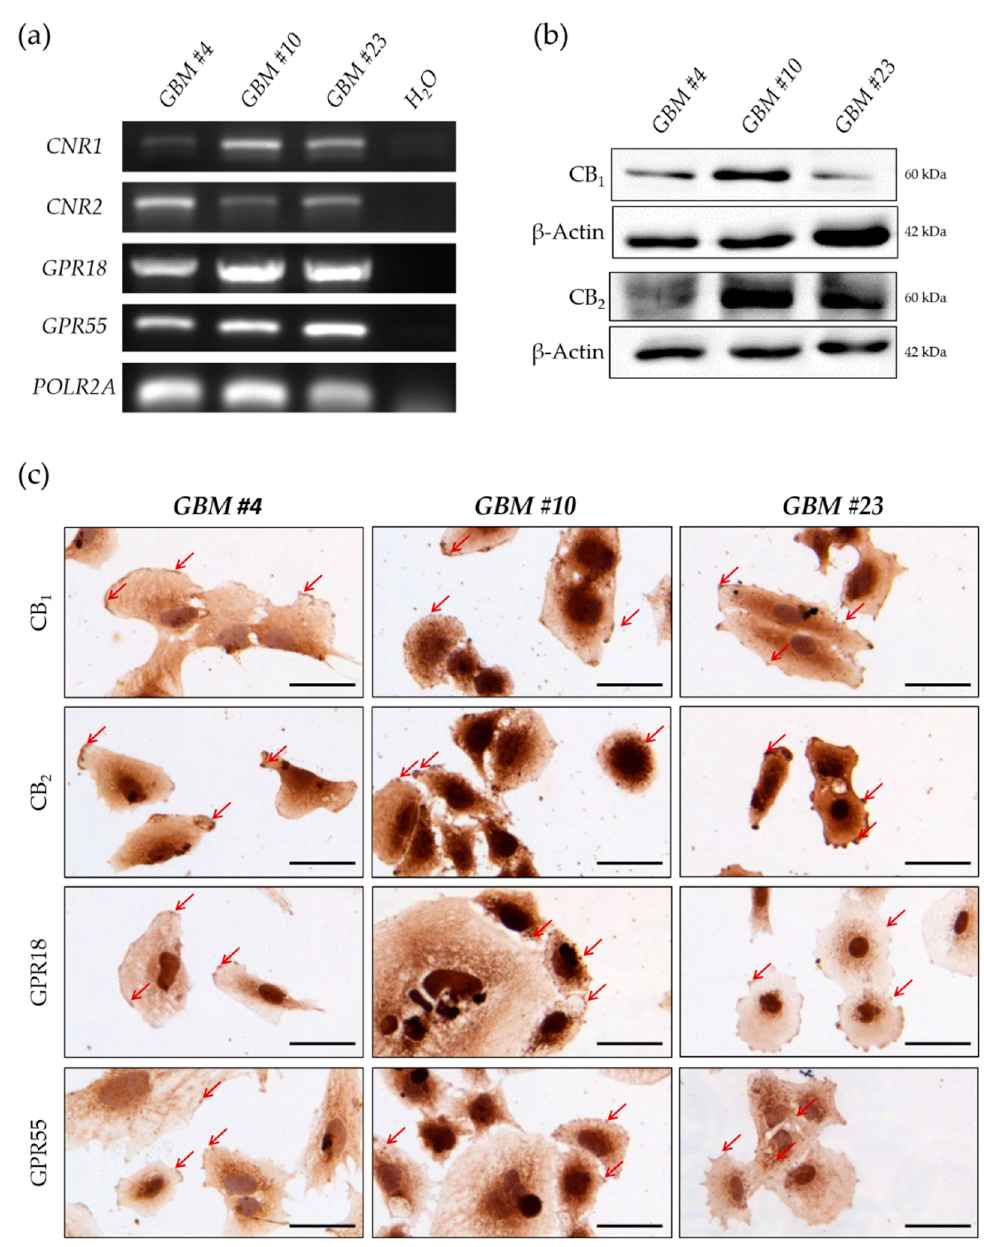
Figure 3. Characterization of human GBM cells regarding their expression of classical and orphan cannabinoid receptors. ( a ) mRNA for human CB 1 ( CNR1 ), CB 2 ( CNR2 ), GPR18 ( GPR18 ), and GPR55 ( GPR55 ) receptors were present in all GBM cells. RNA polymerase II subunit A ( POLR2A ) was used as a housekeeping gene. ( b ) Western blot analysis revealed the expression of all receptors on protein level. β -Actin was used as loading control. ( c ) Immunochemical staining showing the presence of CB 1 , CB 2 , GPR18, and GPR55 on the cell surface of GBM #4 , GBM #10 , and GBM #23 (red arrows). Nuclei were counterstained using hematoxylin. Scale bar = 50 µm.